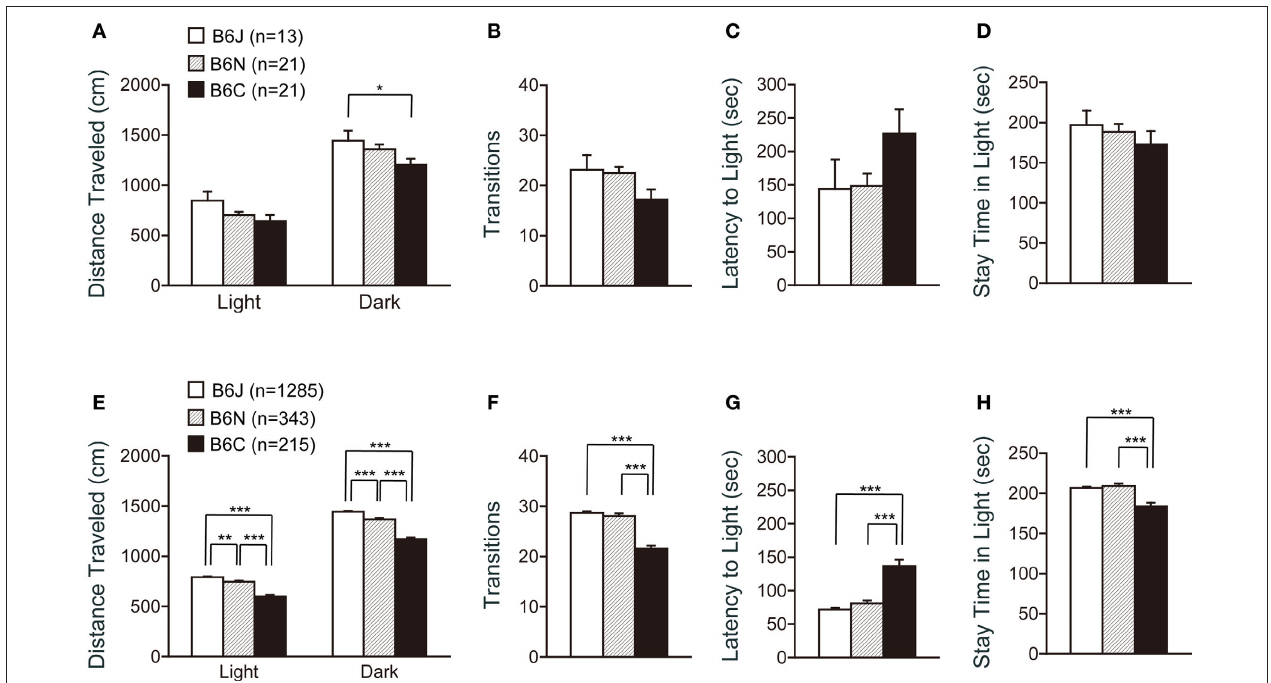
Figure 4 | Light-dark transition test of C57BL/6 substrains. (A–D) Regular scale analysis. (e–H) Large-scale analysis. (A,e) Distance traveled in the light and dark box. C57BL/6J mice traveled the longest distance. (B,F) Number of transitions between the light and dark box. C57BL/6C mice showed the least